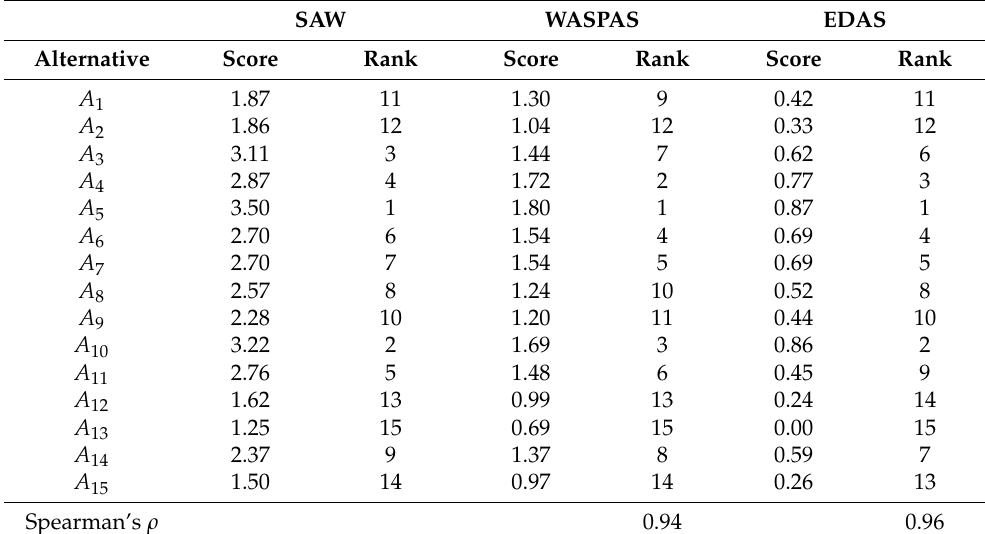
Table 5. Overall scores and their corresponding ranking—SAW, WASPAS, and EDAS methods, crisp